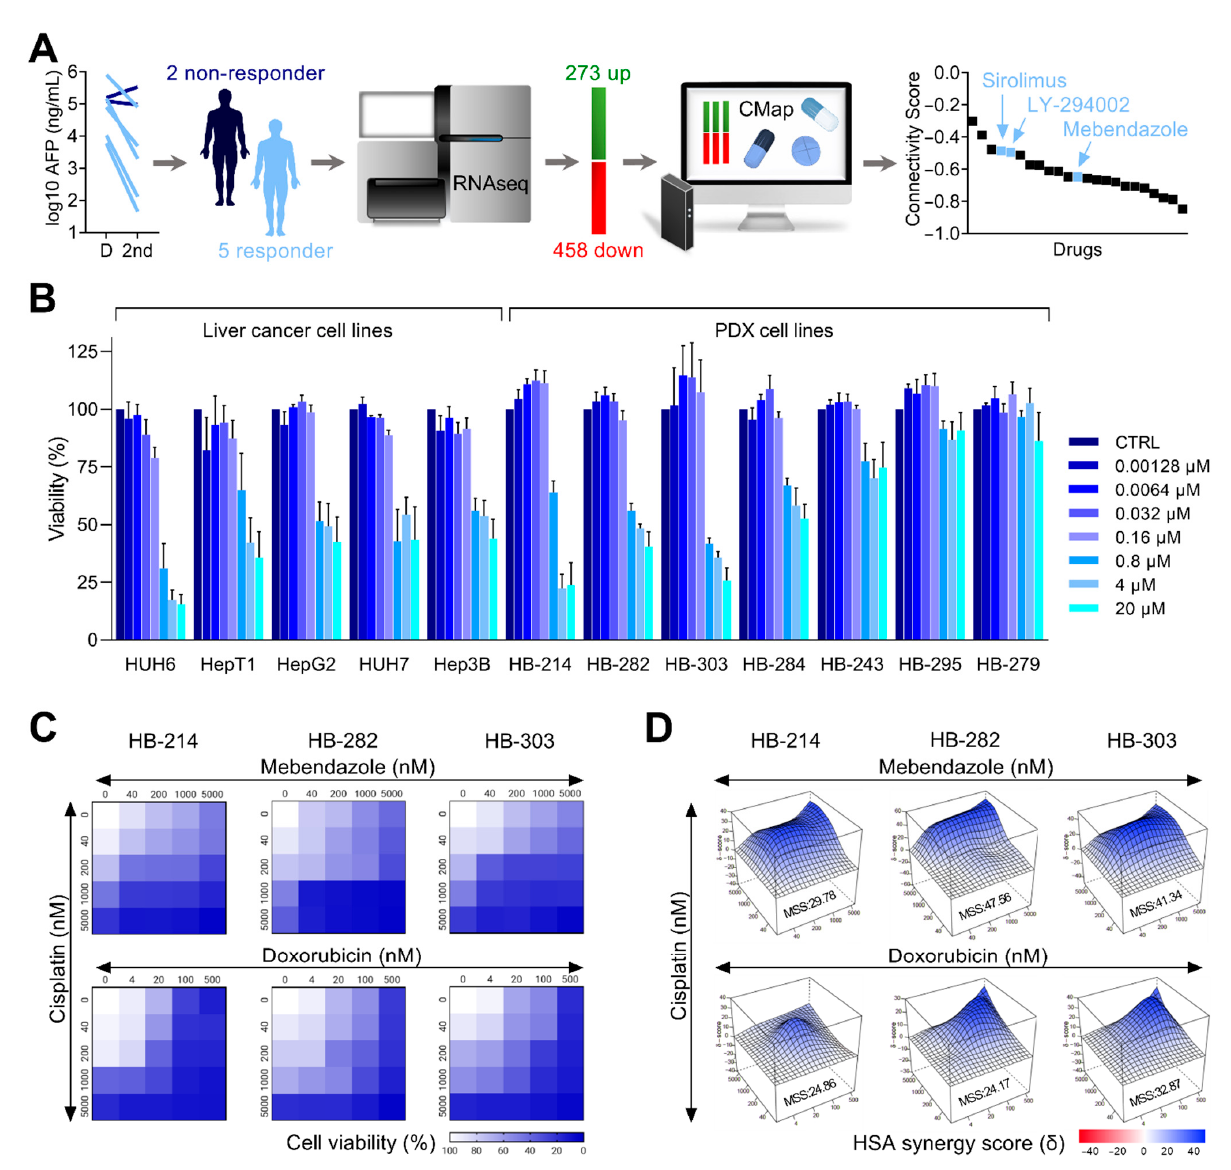
Figure 1. Repurposing of mebendazole for chemoresistant hepatoblastoma. ( A ) Alpha-fetoprotein (AFP) levels in the serum of patients were measured at diagnosis (D) and after the second cycle of chemotherapy (2nd) and are given as log10 ng/mL. Responsiveness to chemotherapy was considered as a decline in AFP level log10 ≥ 1. RNA sequencing data from the 2 non-responders and the 5 responders were retrieved from the Gene Expression Omnibus and differentially expressed genes integrated into Connectivity Map (CMap). The graph shows candidate drugs predicted by CMap with a negative connectivity score indicative of a potential therapeutic value. ( B ) MTT-based viability assays displaying the response of 5 liver cancer cell lines and 7 PDX cell lines towards mebendazole exposure with 7 increasing concentrations ranging from 0.00128–20 µ M. Error bars represent standard error of the mean ( ± SEM) of three independent experiments, each consisting of two replicates. ( C ) Heatmaps displaying the proportions of cell viability upon exposure towards increasing concentrations (given in nM) of cisplatin, mebendazole, and doxorubicin in a two-drug combination matrix format (n = 2, duplicates). ( D ) Three-dimensional synergy landscapes shown separately for each two-drug combination of cisplatin, mebendazole, and doxorubicin, as calculated from cell viability assays (n = 2, duplicates). Maximum synergy scores (MSS) were calculated via Synergyfinder2.0 software with the HSA